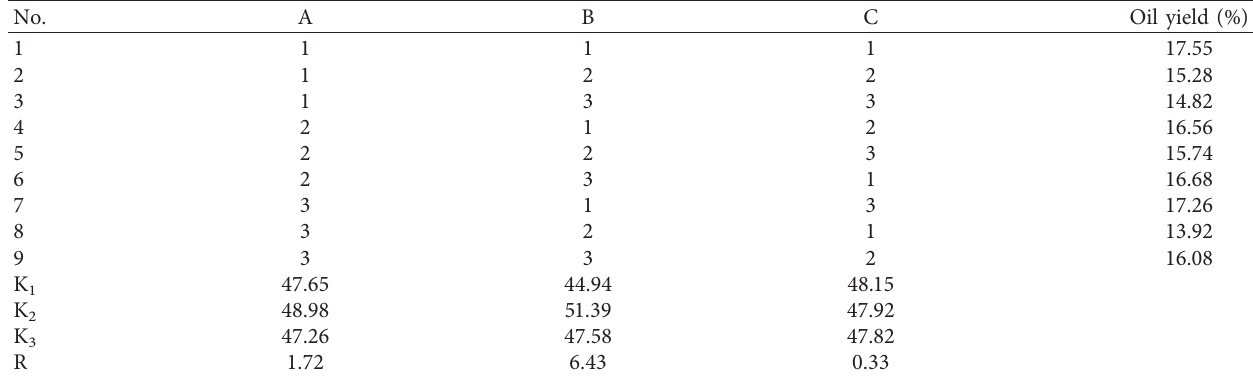
Table 8: Orthogonal experimental design and results of supercritical extraction of palm seed oil.